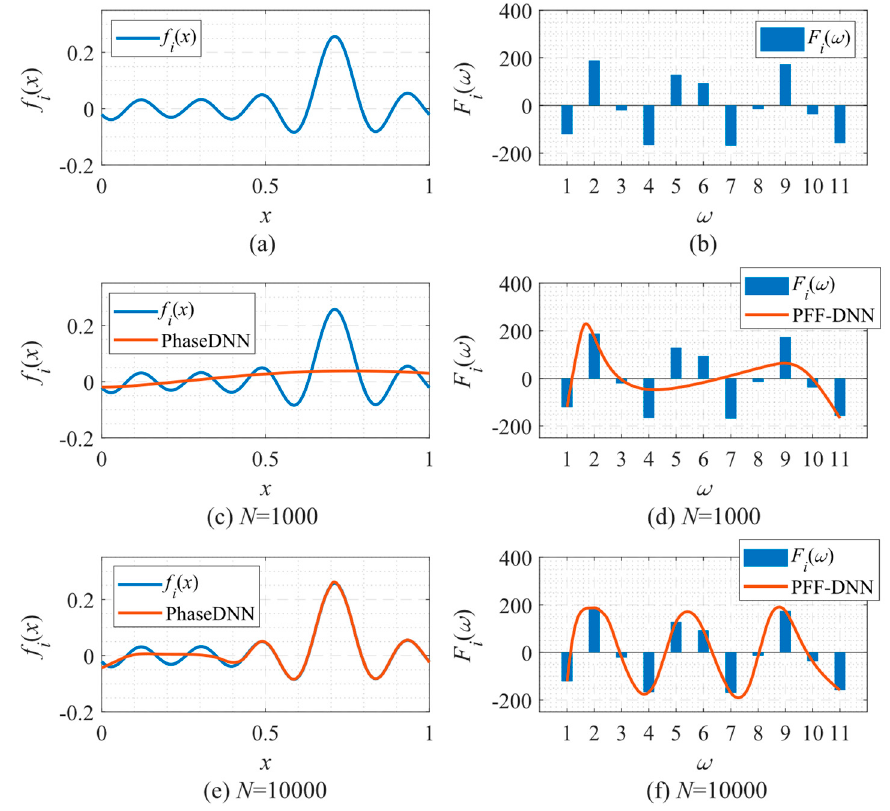
Figure 30. Approximation performance during training. ( a ) The third frequency band of the fitted function (the real part after frequency shift); ( b ) the spectrum (real part) of the function in ( a ); ( c ) fitting results of PhaseDNN after 1000 updates; ( d ) fitting results of PFF-DNN after 1000 updates; ( e ) fitting results of PhaseDNN after 10,000 updates; and ( f ) fitting results of PFF-DNN after 10,000